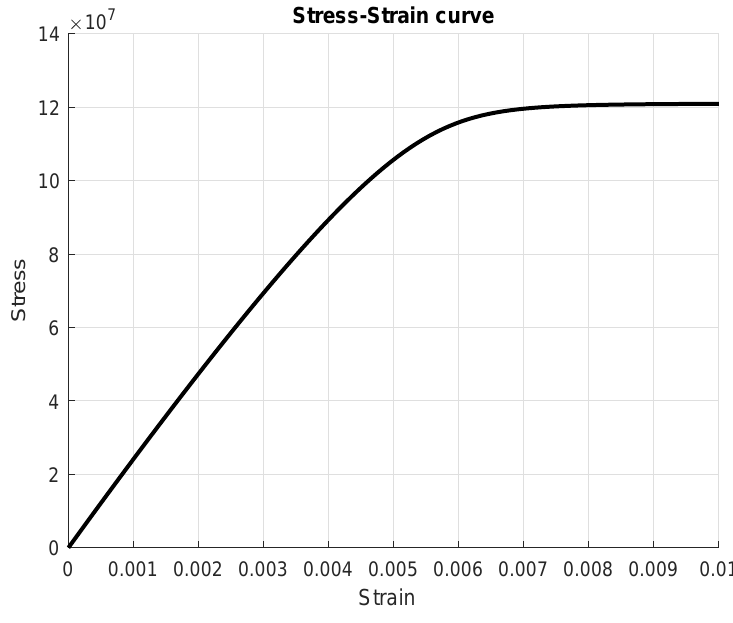
Figure 3. Stress-Strain curve obtained with the García et al. model in a tensile test. Figure 3. Stress–strain curve obtained with the García et al. model in a tensile test.